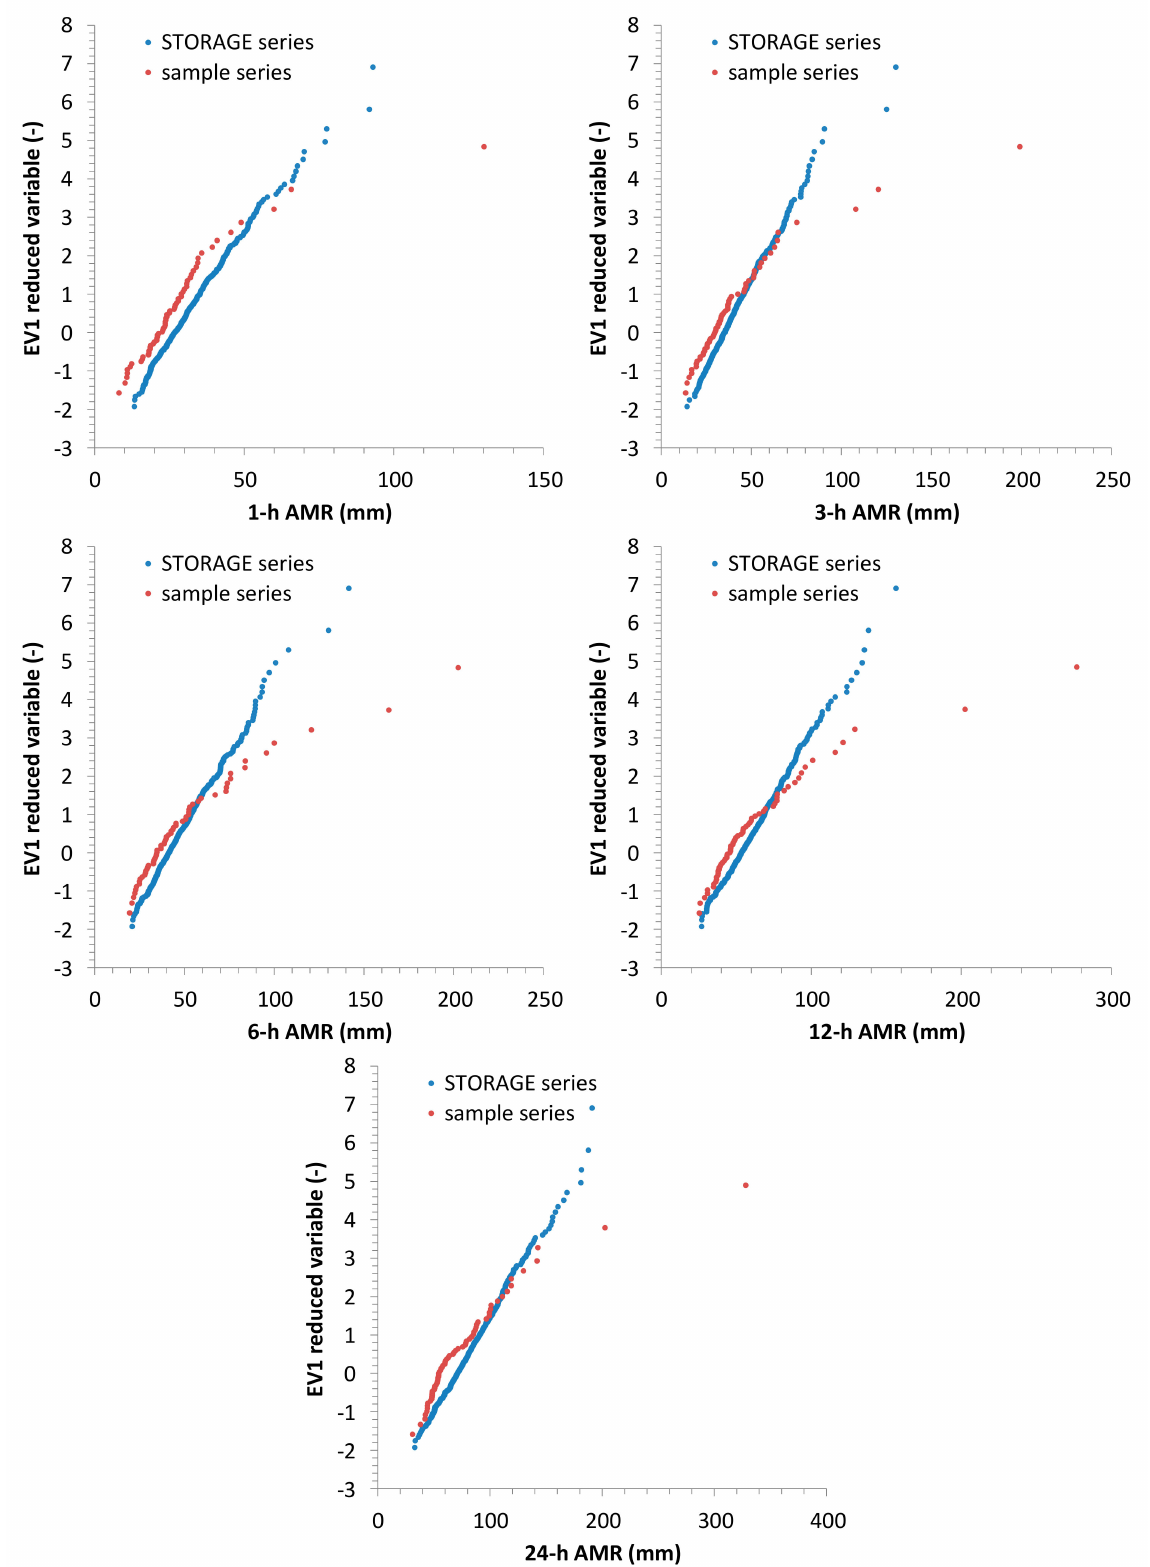
Figure 20. Vibo Valentia rain gauge: EV1 probabilistic plots, showing the comparison among synthetic and observed AMR